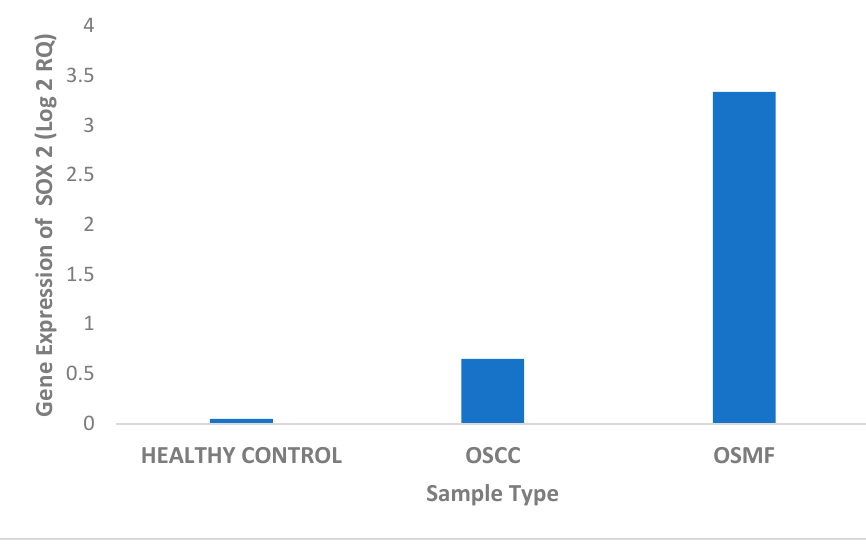
Table 5. Expression levels of SOX 2 in OSCC, OSMF and healthy control samples.